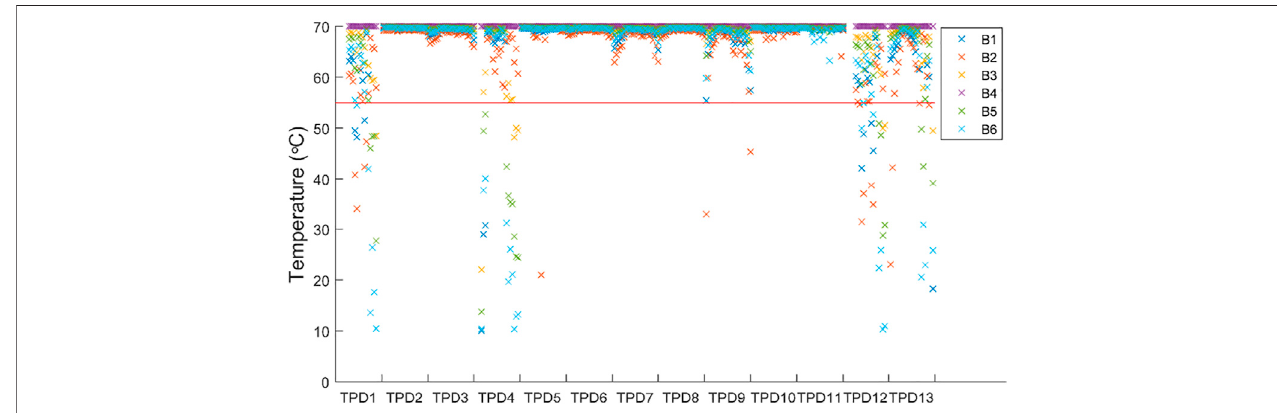
FIGURE 8 | Temperature delivered at the buildings during the simulation